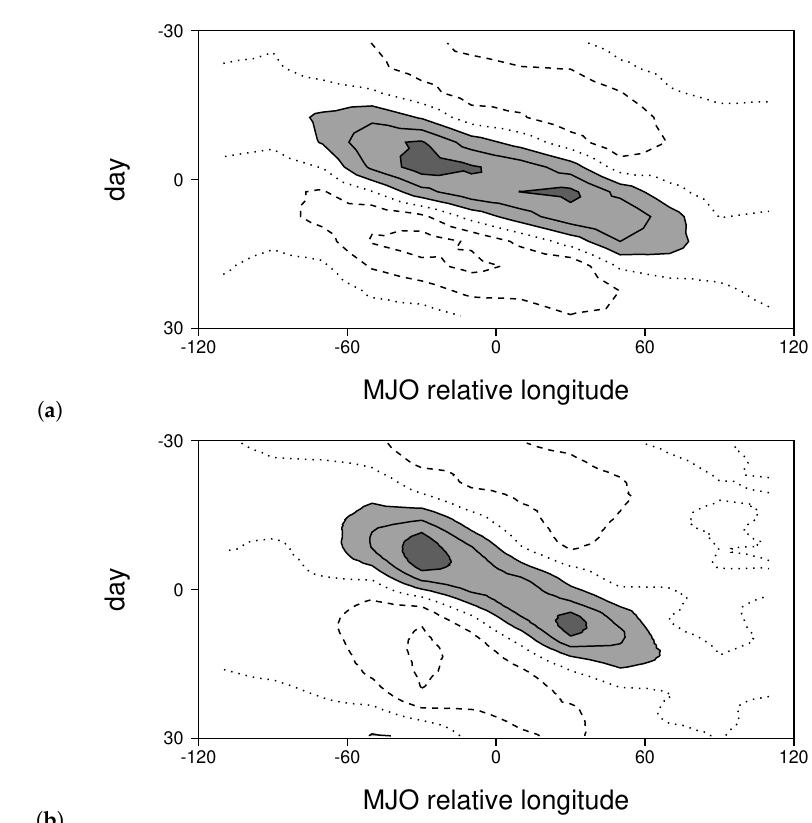
Figure 5. Composite MJO rainfall time-longitude series. ( a ) First 30 years of the LCM simulation (15–75 day bandpass filter, 0.4 mm/day contour interval, zero contour dotted, values greater than 0.4 (1.2) mm/day shaded light (dark) gray). ( b ) Observed MJO from [6] (5–75 day bandpass filter, 1 mm/day contour interval, zero contour dotted, values greater than 1 (3) mm/day shaded light (dark)